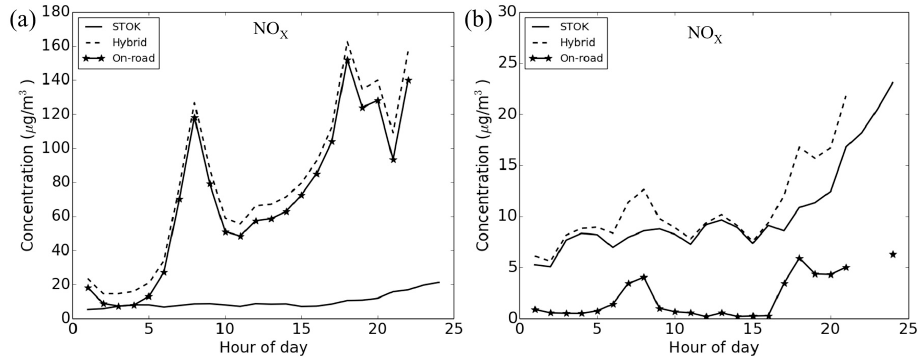
Figure 4. Time series plot on January 3rd for NO x at ( a ) a near-road Census block (14.1 m from roadway); and ( b ) a remote Census block (9.6 km from